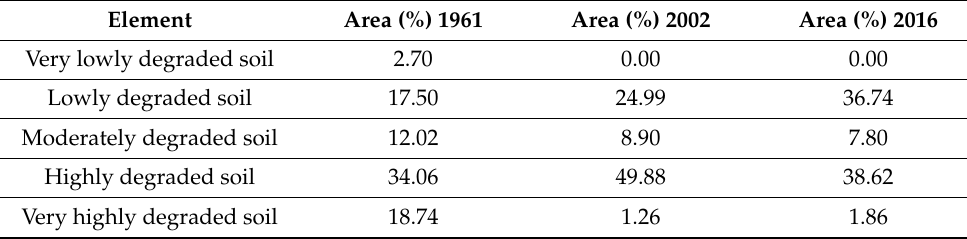
Table 7. Overall qualitative soil degradation change in 1961, 2002, and